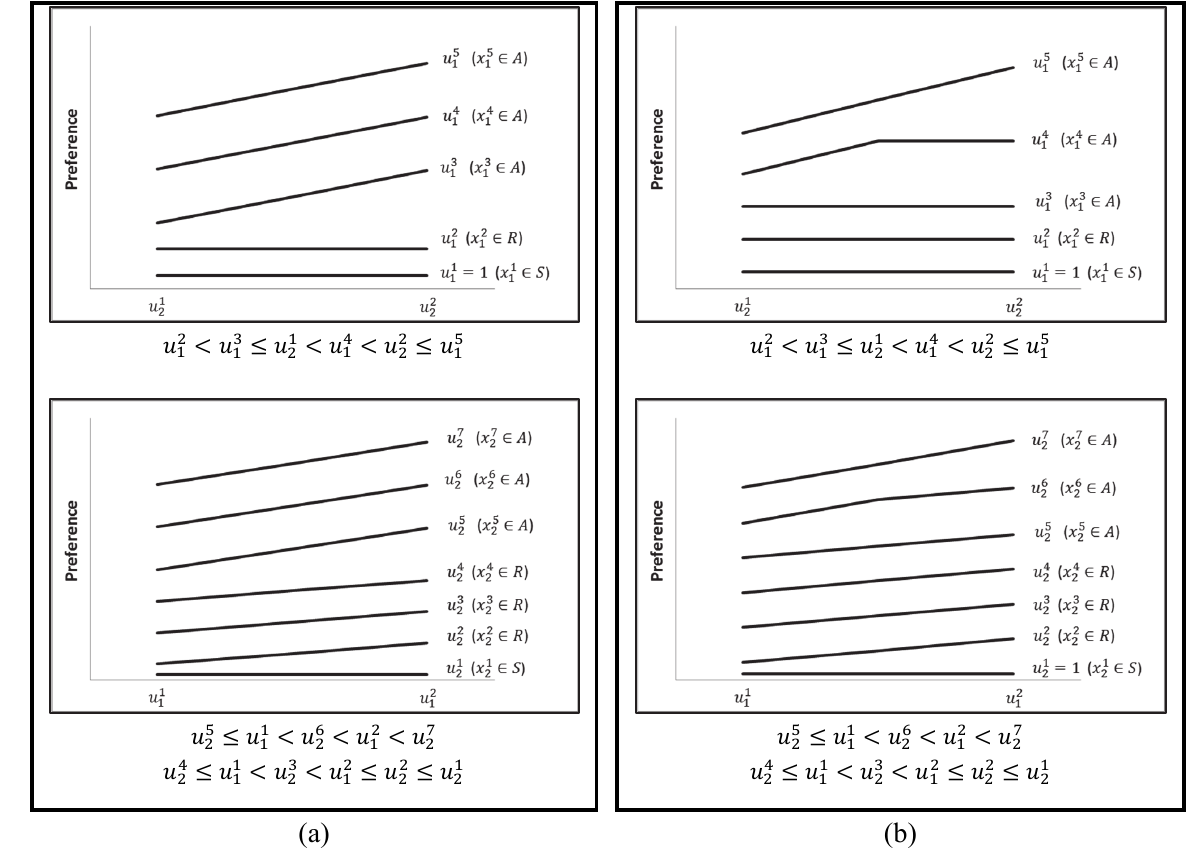
Fig. 9. (a) Preference structure of the DM as illustrated by Fig. 7. (b) Preference structure that can be modeled by the Choquet integral with respect to the 4-ary